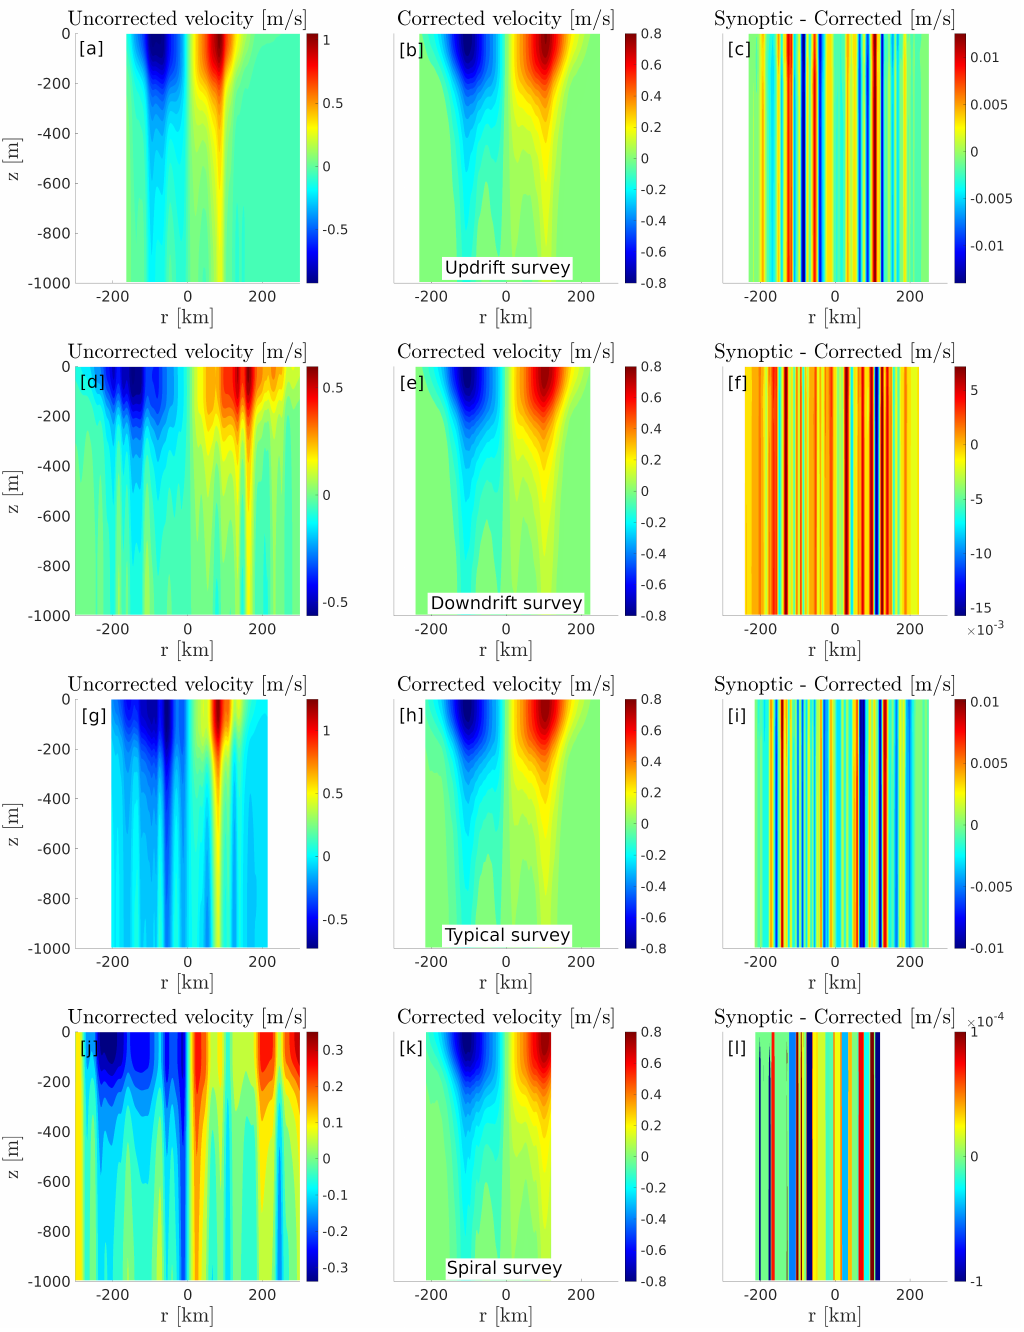
Figure 7. Left hand side panels ( a , d , g , j ): Geostrophic velocity sections computed from the raw synthetic glider data using the traveled distance as the reference horizontal coordinate. Central panels ( b , e , h , k ): Geostrophic velocity sections computed using the relocation method. Right hand side panels ( c , f , i , l ): Difference between the synoptic and the corrected velocity sections. The first row of panels represent the updrift survey, the second row the downdrift survey, the third row the typical survey, and the bottom row the spiral